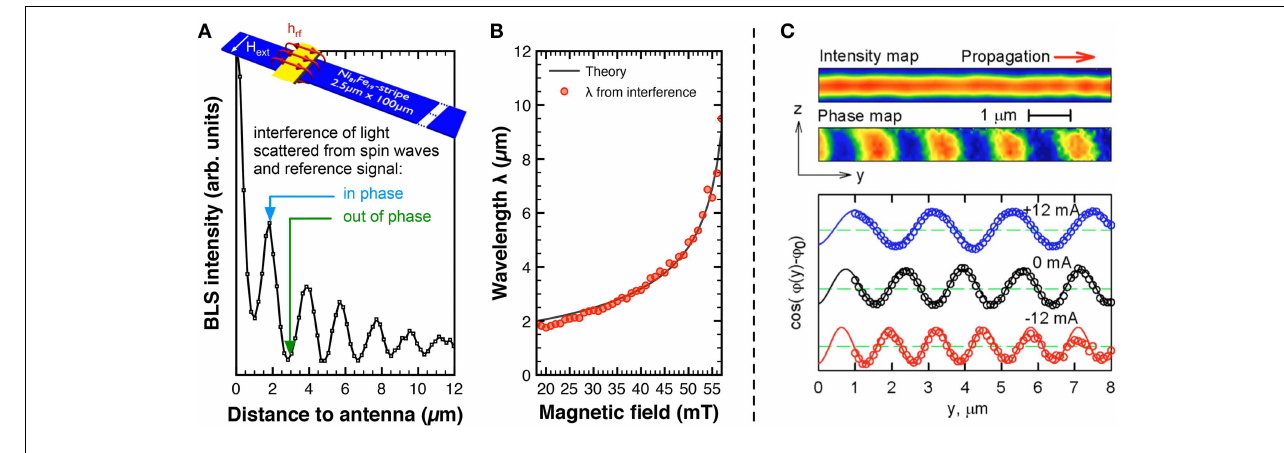
FIGURE 12 | Examples of phase-resolved BLS measurements. (A) Interference signal of light scattered on spin waves in a spin-wave waveguide and the reference beam. The distance between two maxima (minima) yields the wavelength of the propagating spin wave. From Vogt et al. [120]. (B) Spin-wave wavelengths measured for different applied magnetic fields